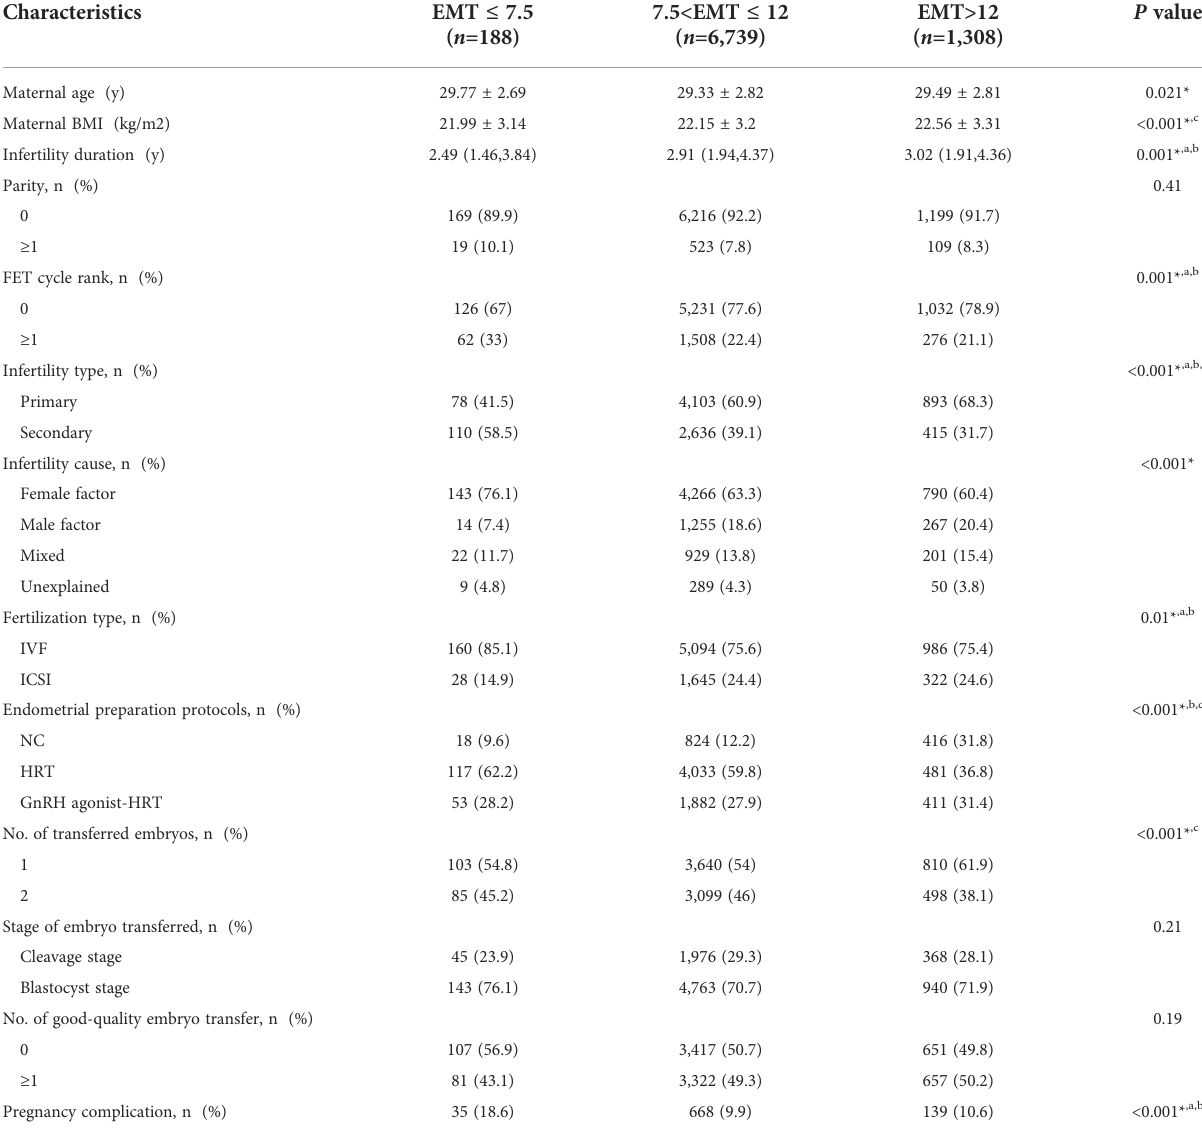
TABLE 1 Baseline characteristics according to EMT strati fi cation.